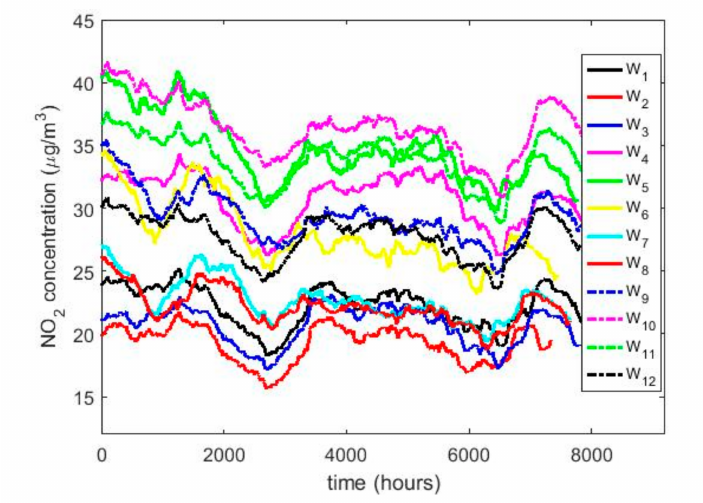
Figure 10. Moving average of the NO 2 concentrations: W 1 (0:00–1:00), W 2 (2:00–3:00), W 3 (4:00–5:00), W 4 (6:00–7:00), W 5 (8:00–9:00), W 6 (10:00–11:00), W 7 (12:00–13:00), W 8 (14:00–15:00), W 9 (16:00–17:00), W 10 (18:00–19:00), W 11 (20:00–21:00), and W 12